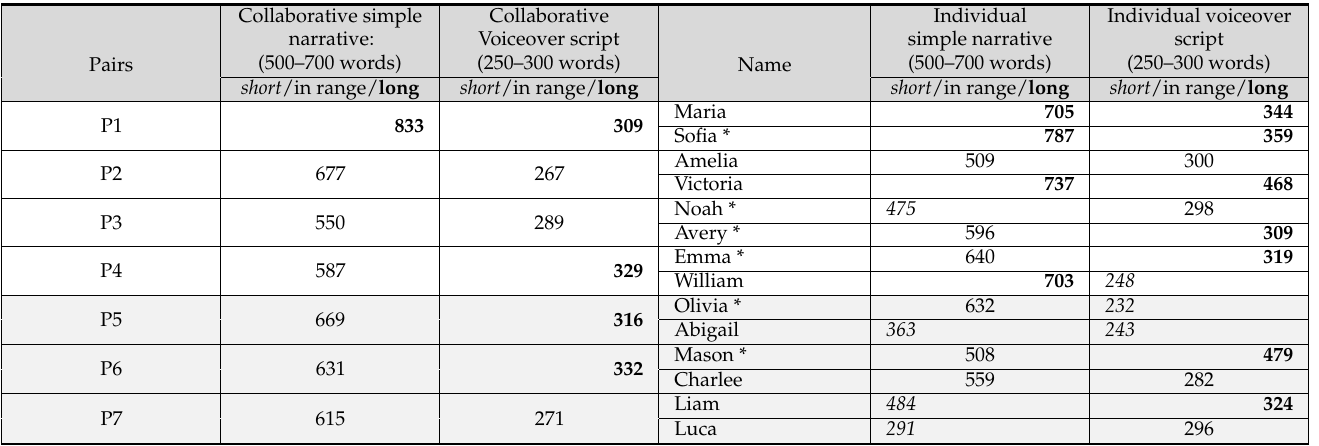
Table 6. Word count for transformation of simple narrative to voice-over script. P1–4 = SHLs; P5–7 =